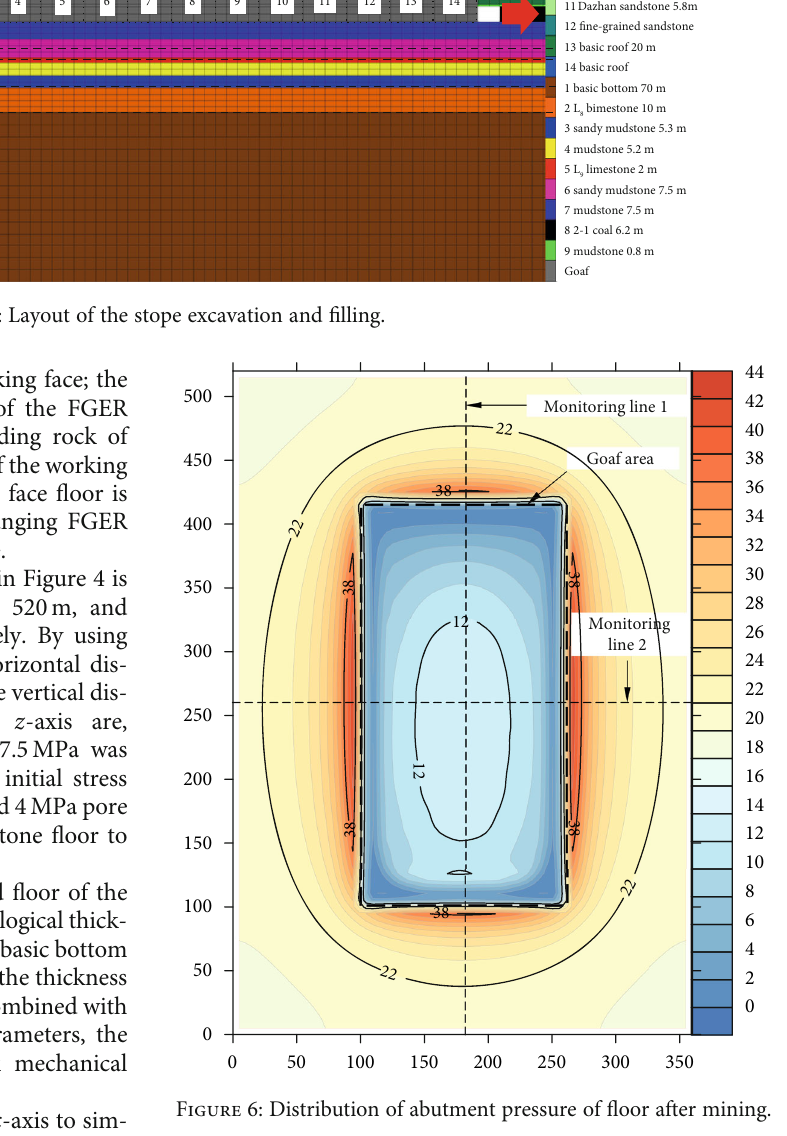
Figure 6: Distribution of abutment pressure of fl oor after